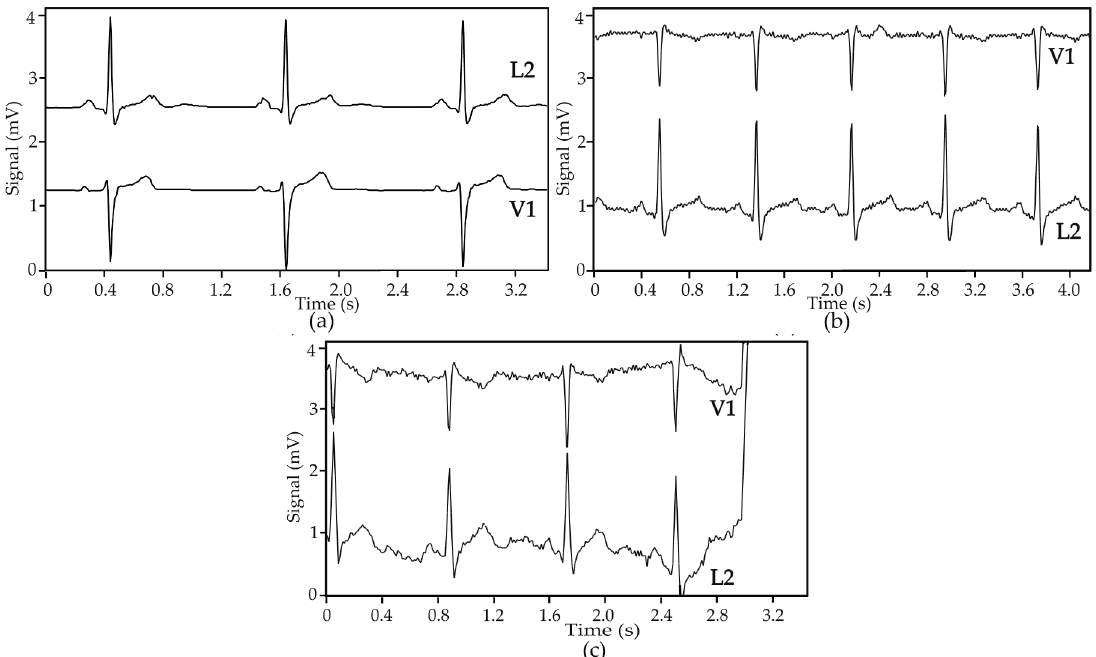
Figure 11. ECG signals obtained in ambulatory with a Holter monitoring device and patient ID = 1: ( a ) gel electrodes, rate 50 BPM; ( b ) textile electrodes, rate 74 BPM; and ( c ) textile electrodes, rate 71 BPM, showing motion artefact interference leading to a loss of signal.